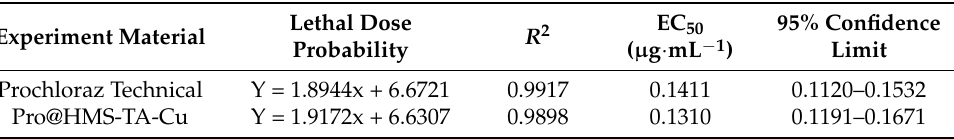
Table 2. Antifungal activity (EC 50 ) of the prochloraz technical and the Pro@HMS-TA-Cu against S. sclerotiorum .